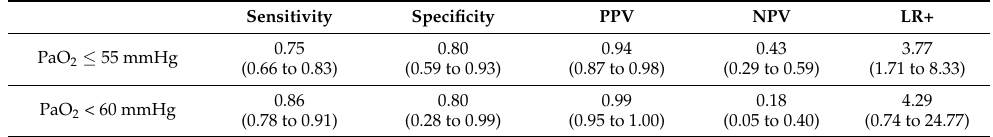
Table 4. Diagnostic accuracy of the AGM100 device to diagnose severe resting hypoxemia in